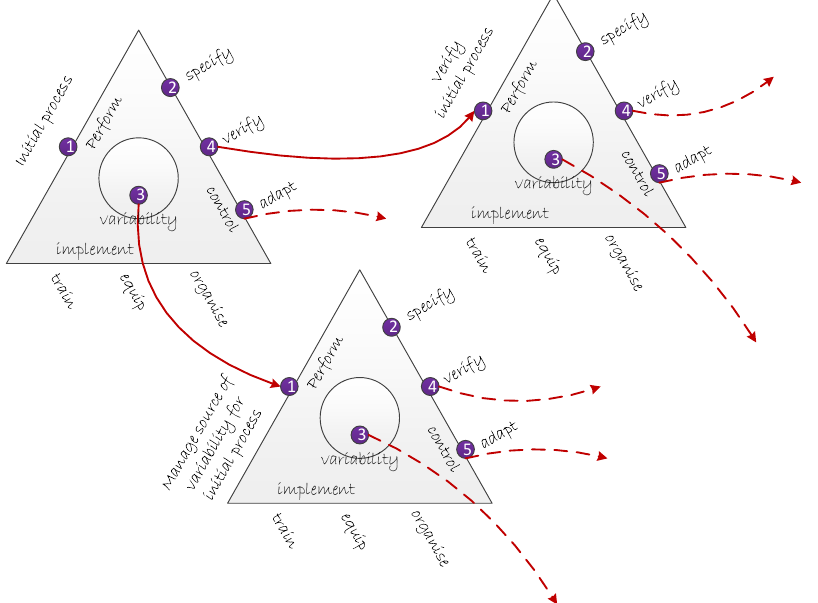
Figure 2. Graphical representation of linked functions following the SAFRAN logic.